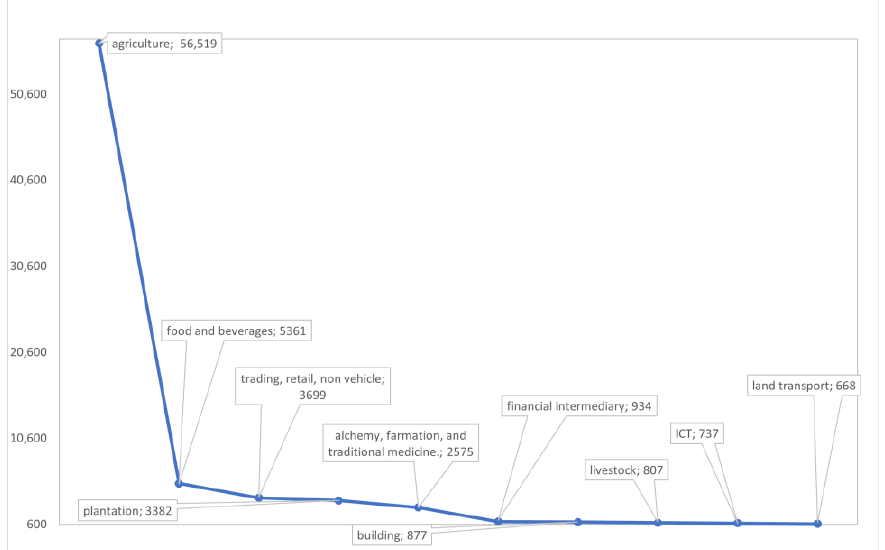
Figure 2. Sectors Affected by Implementation of Maritime Security Policy from total Labor (Source: [16]).